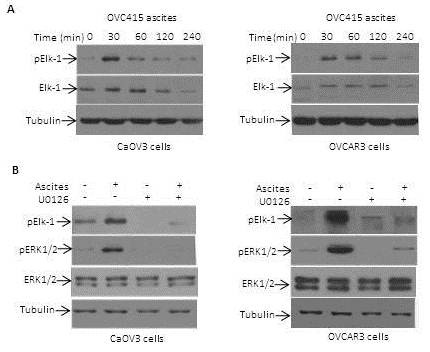
Elk-1 is activated by ascites and its activation is controlled by ERK1/2. (A) Cells were treated with OVC415 ascites (10%) for up to 240 min and the expression and phosphorylation of Elk-1 was assessed by immunoblot. Activation of Elk-1 was detected with an anti-phospho-Elk-1 antibody specific for Ser383. Tubulin was used as a control for loading. (B) Cells were treated with U0126 for 1 h before the addition of OVC415 ascites (10%). Lysates were obtained 1 h after the addition of ascites and immunoblot analysis was performed with anti-phospho-ERK1/2 and anti-phospho-Elk-1 antibodies. Representative data from three independent experiments.